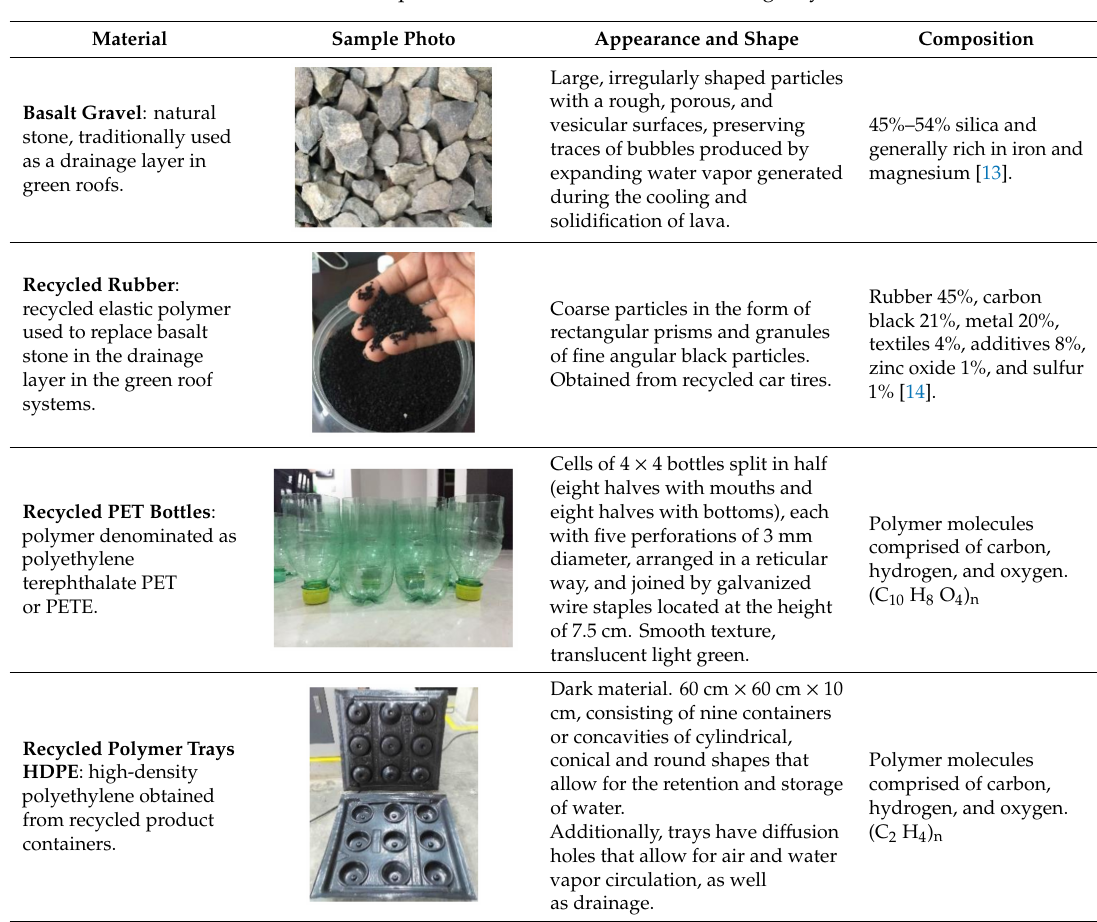
Table 2. Description of materials selected for drainage layers.